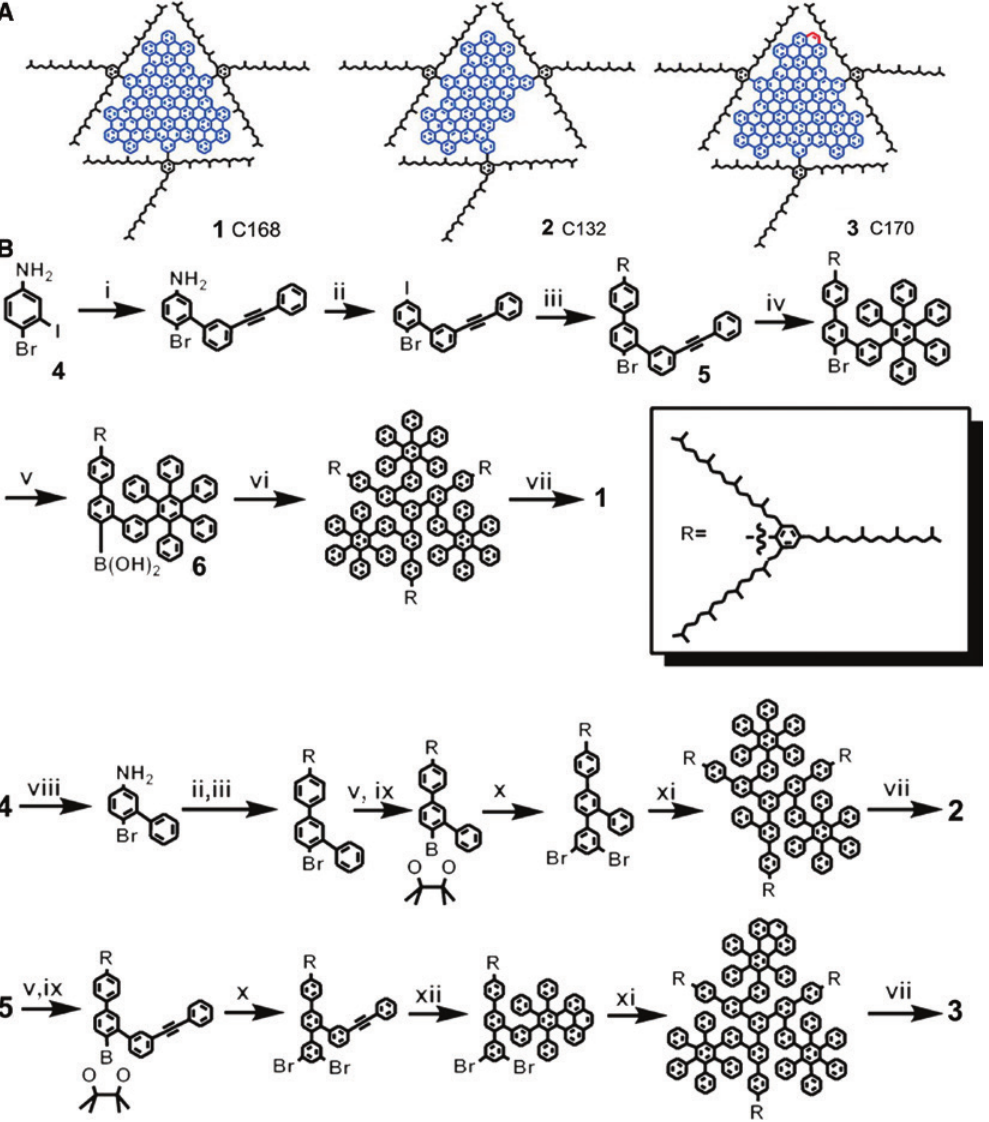
Figure 13: The synthesis process of graphene quantum dots and their molecular structures. (A) Structure of graphene quantum dots 1–3. (B) Synthesis of graphene quantum dots 1–3 (reprinted/reproduced with the permission of Ref. [74], copyright 2010, American Chemical Society).